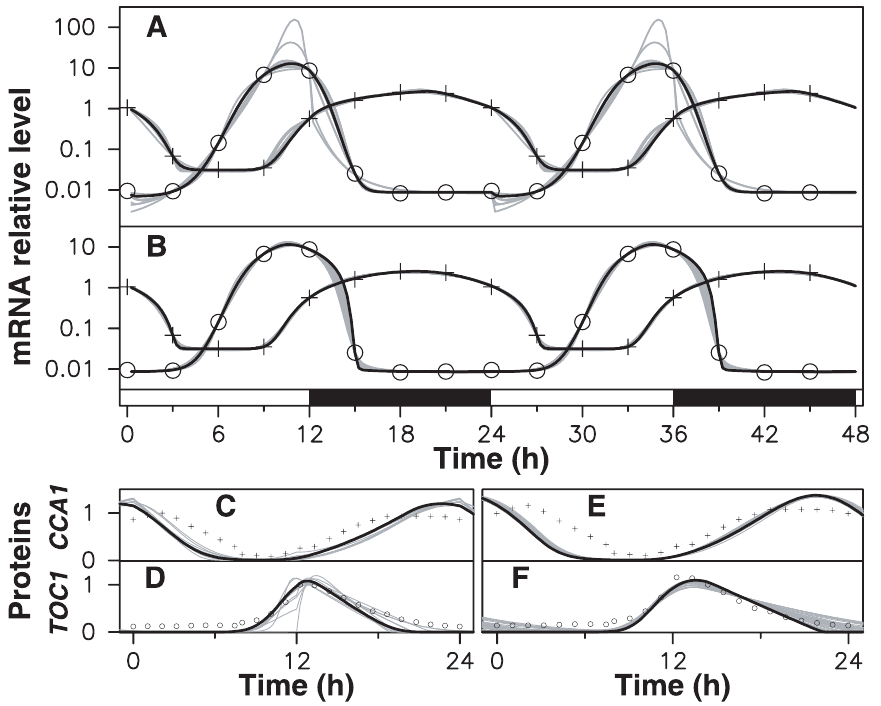
Figure 2. Adjustment of experimental data. The data of Fig. 1(A) are adjusted by model (2) with a FRP of 24 hours. In (A) and (B), crosses (resp. circles) indicate the Cca1 (resp. Toc1 ) microarray data used as target. Solid lines are best-fitting mRNA time profiles (log scale) obtained with models where (A) all parameters are coupled to light; (B) no parameter is coupled to light; a few solutions near optimum are shown in gray with the best one in black. (C) (resp. (E)) solid lines are CCA1 predicted time profile (linear scale) corresponding to (A) (resp. (B)) with the same color code; crosses correspond to luminescence signals from translational fusion lines. (D) and (F) are the same curves as (C) and (E) for the TOC1 protein.